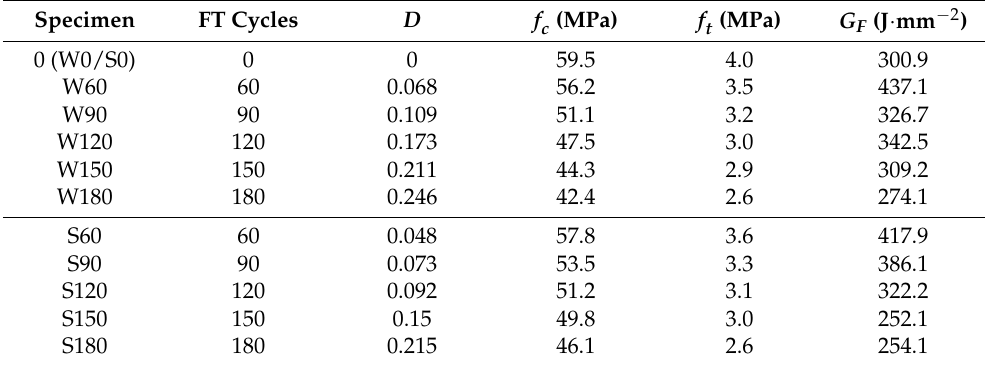
Table 4. Mechanical properties of notched beams subjected to freeze–thaw